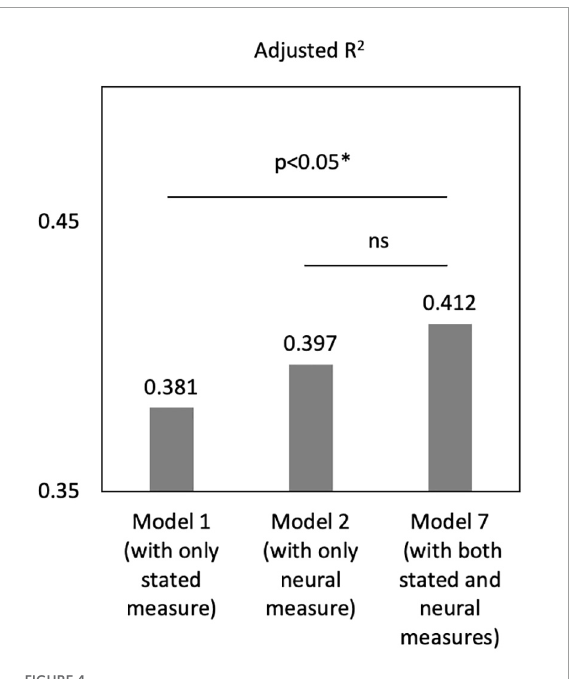
FIGURE4 The model fit comparison of model 1, 2 and 7. ∗ p <